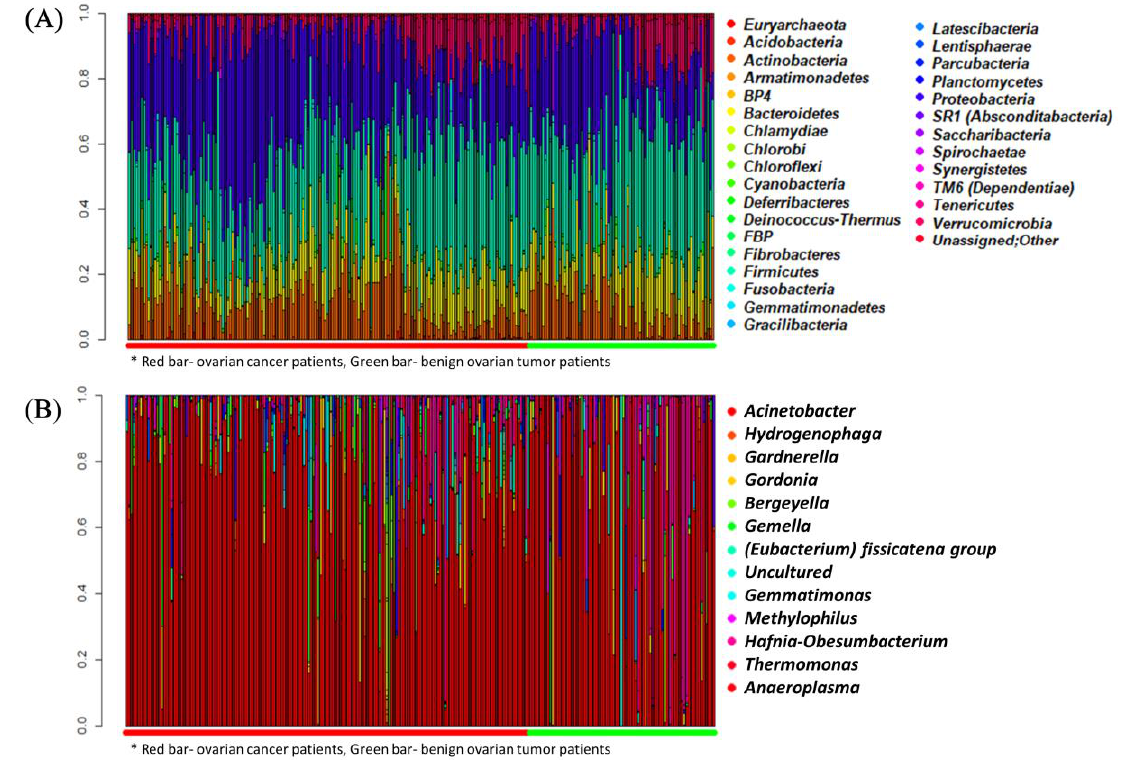
Figure 1. Landscape of metagenomic profiles in all patients. ( A ) Phylum-level composition. ( B ) Genus-level composition. Below the plot, red and green horizontal bars indicate ovarian cancer patients and benign ovarian tumor patients, respectively.